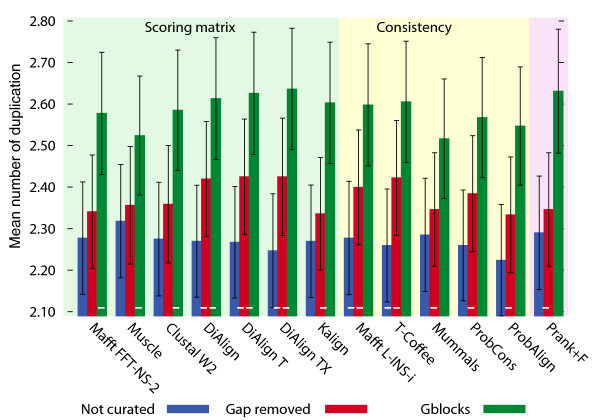
Effect of excluding gaps and variable regions. The plot shows the effect of filtering on the minimum duplication test with back-translated, fungal amino-acid alignments. Removing gapped sites tends to worsen the accuracy of the induced maximum likelihood trees. Removing variable regions in addition to gapped sites (Gblocks, default settings) drastically reduces the accuracy of reconstructed trees. Error bars correspond to ± 1 s.d. Significant difference between results from original and curated alignments is denoted with a minus symbol at the basis of relevant bars (Wilcoxon double-sided test, P < 0.01).